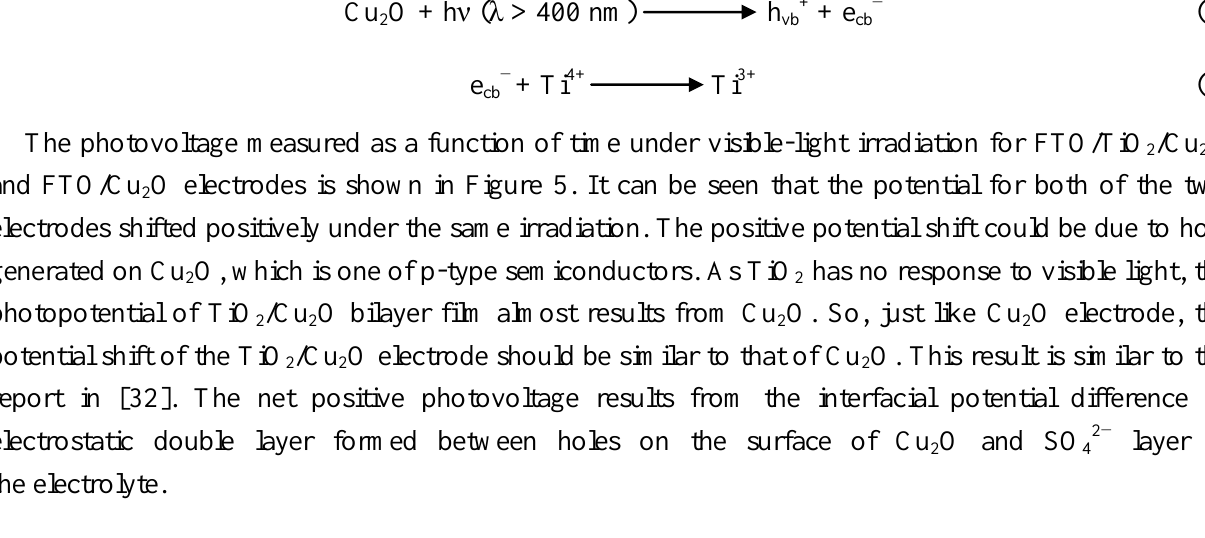
Figure 4. Sketch of interfacial electron transfer in TiO